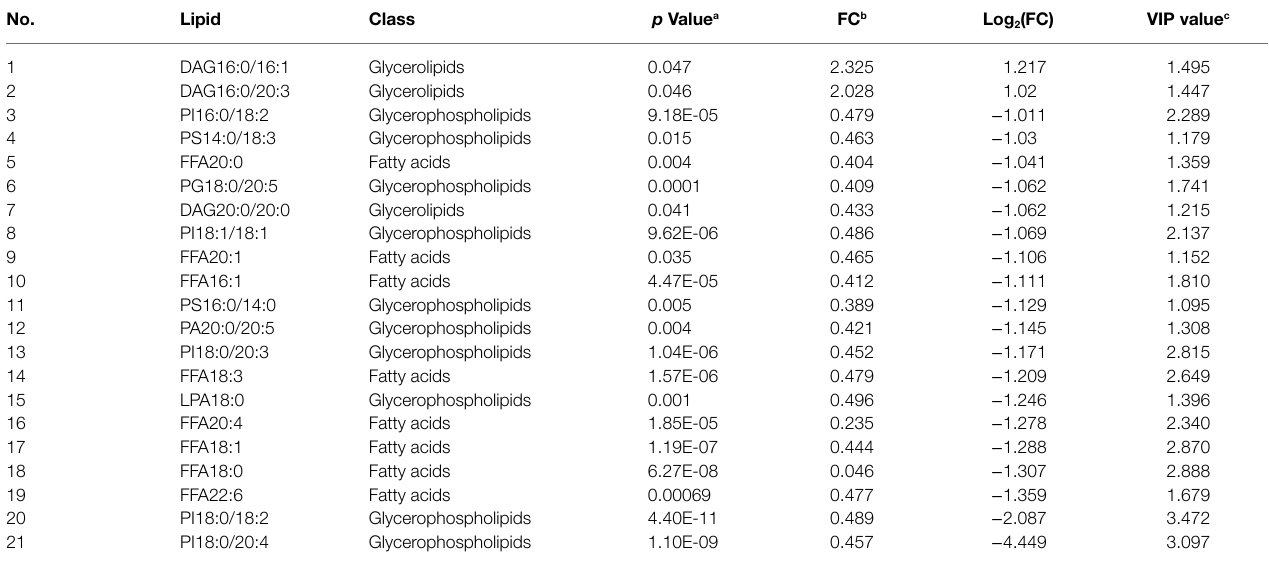
TABLE 2 | Lipids with different levels between patients with NPC and